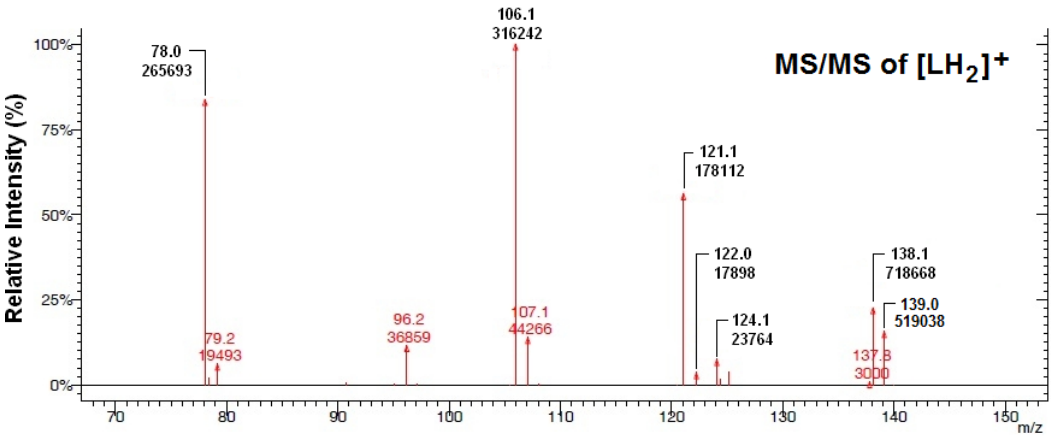
Fig. S2. Tandem mass spectrum of [LH